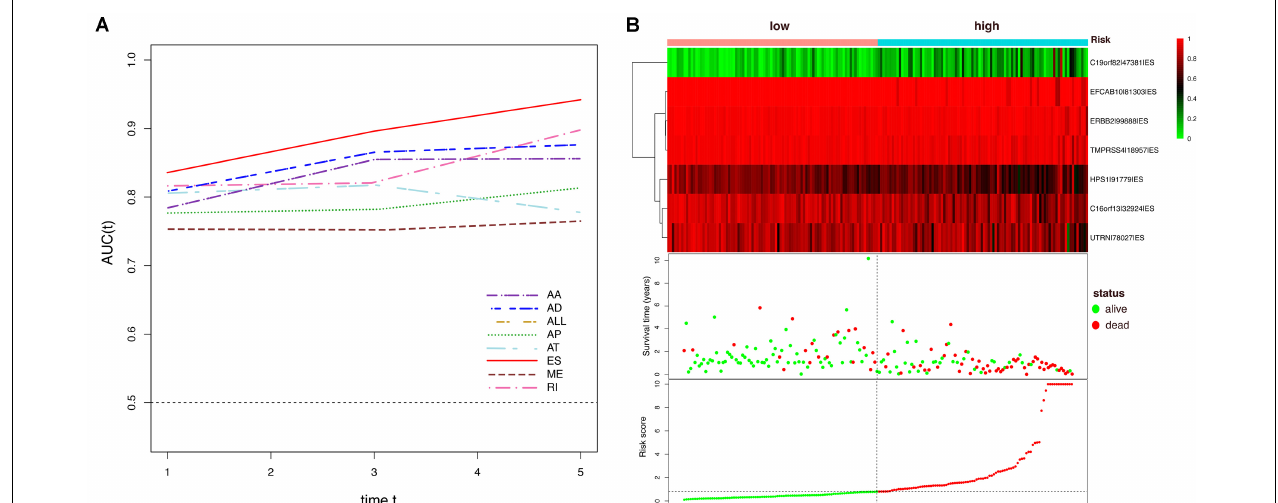
FIGURE 7 | Dynamic AUC values of ROC curves for each AS model and determination of the ES prognostic signature in the ESCA cohort. (A) The curves of time-dependent AUCs versus time (1–5 years) of each signature: AUC(t) versus t (B) Patients were divided into high- and low-risk subgroups based on the median of risk scores based on the ES prognostic predictor. The upper part is the heatmap of AS events involved in the prognostic predictor, color transition from green to red indicates the increasing PSI score of corresponding AS event from low to high. The middle part is the survival status and survival time of each individual. Color of each plot represents the survival status of each patient. The bottom part is risk score of each individual.